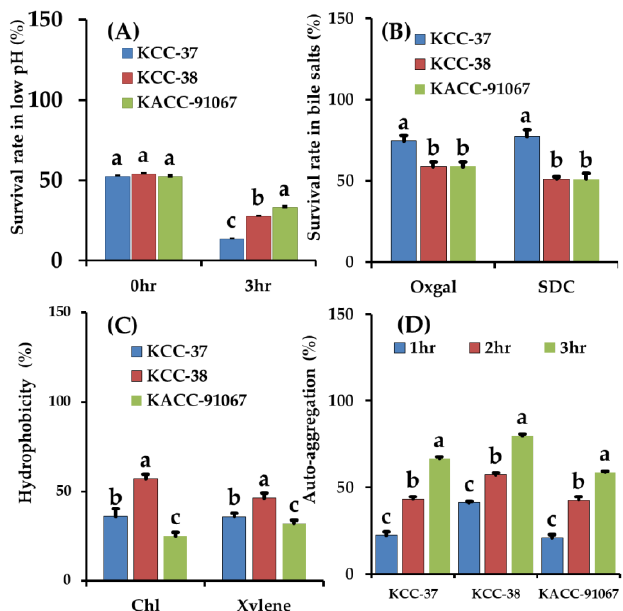
Figure 4. Probiotic features of L. plantarum KCC-37 and L. plantarum KCC-38- In-vitro